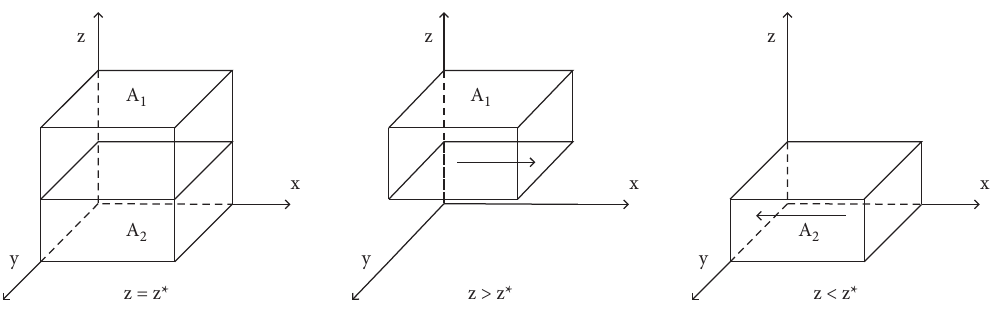
Figure 2: Phase diagram of social organizations’ strategy